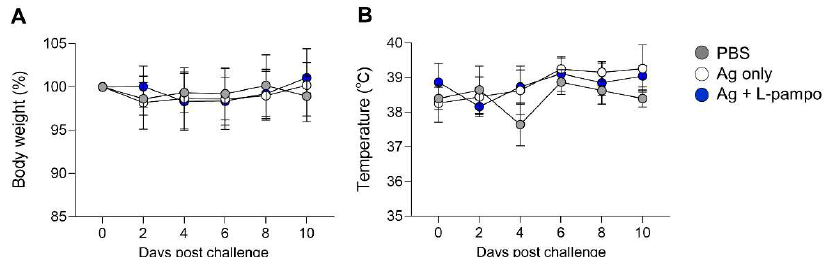
Figure 6. Signs of clinical symptoms after SARS-CoV-2 virus challenge. Immunized ferrets (total n = 16, n = 4/PBS; n = 6/Ag only; n = 6/Ag + L-pampo) were intranasally challenged with 10 5.5 TCID 50 / mL SARS-CoV-2 (Korea Centers for Disease Control and Prevention, resource no. 43326) under anesthesia. The body weight (%) ( A ) and temperature (°C) ( B ) of ferrets on days 2, 4, 6, 8, and 10 after SARS-CoV-2 virus challenge. Data shown are mean ± SD.